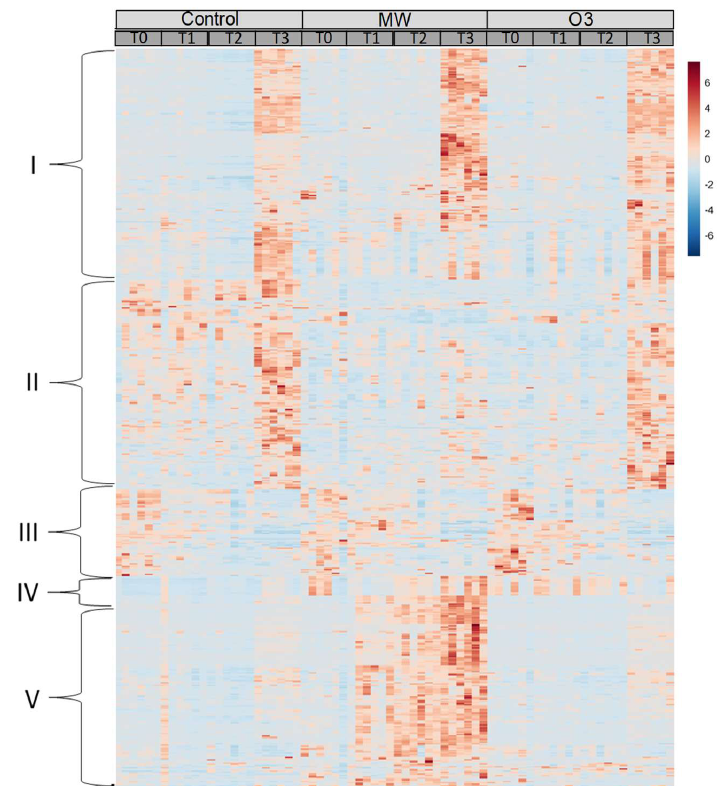
Figure 2. Heatmap plot of the 646 significant metabolic features determined by a two-way ANOVA on time and treatment ( p < 0.001) at T0, T1 (24 h), T2 (48 h), and T3 (72 h) after the application of the stresses (O 3 or MW). The red and blue colors indicate a higher and lower intensity level for each metabolic feature, respectively. Each line refers to a single metabolic feature. Each column refers to a sample. Clusters of significant metabolic features are identified by the mark on the left. Each cluster is depicted in the Results Section.